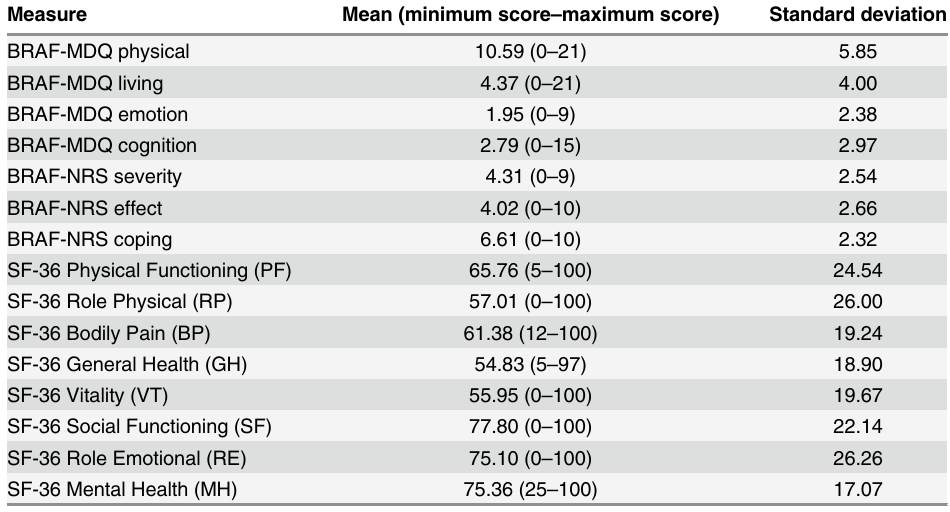
Table 3. Sample means on BRAF-MDQ (N = 164), BRAF-NRS (N = 165) and SF-36 (N =